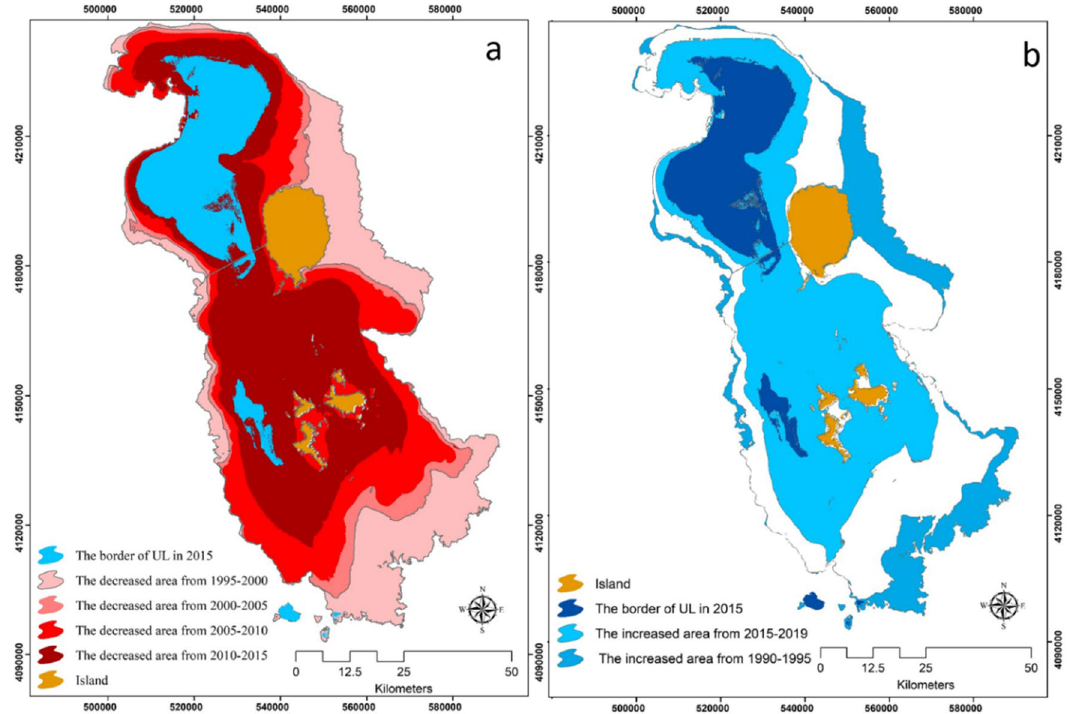
Figure 2. Observed changes of the Urmia Lake area from 1990 to 2020 based on the satellite images: ( a ) shows how the area of the lake has decreased over time, and ( b ) shows the periods of increased water body